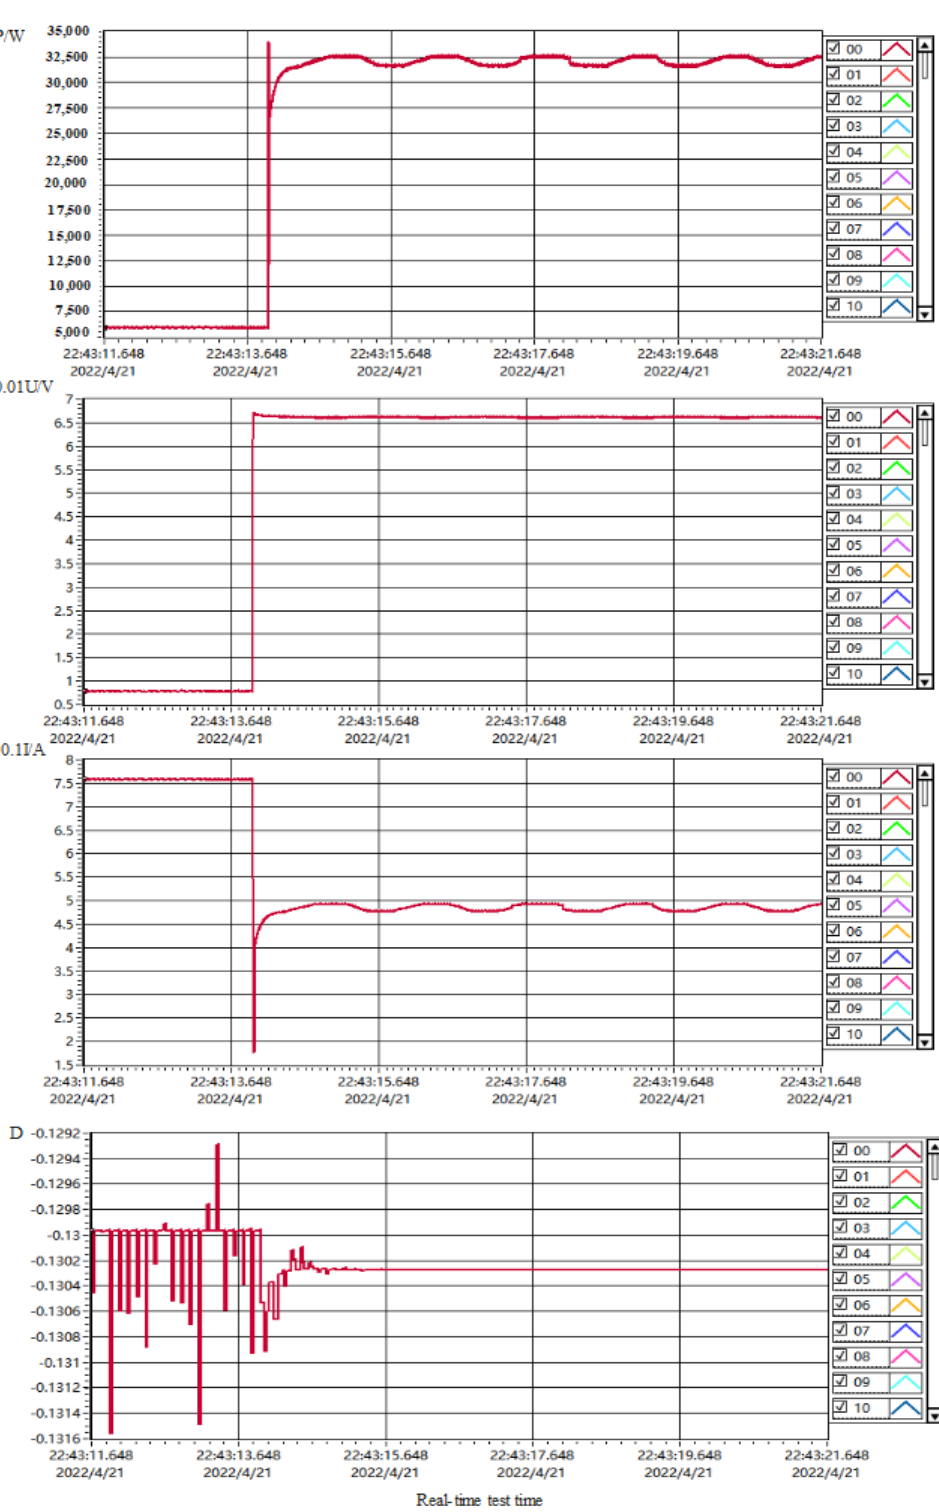
Figure 15. PSO output curves based on real-time simulation platform.